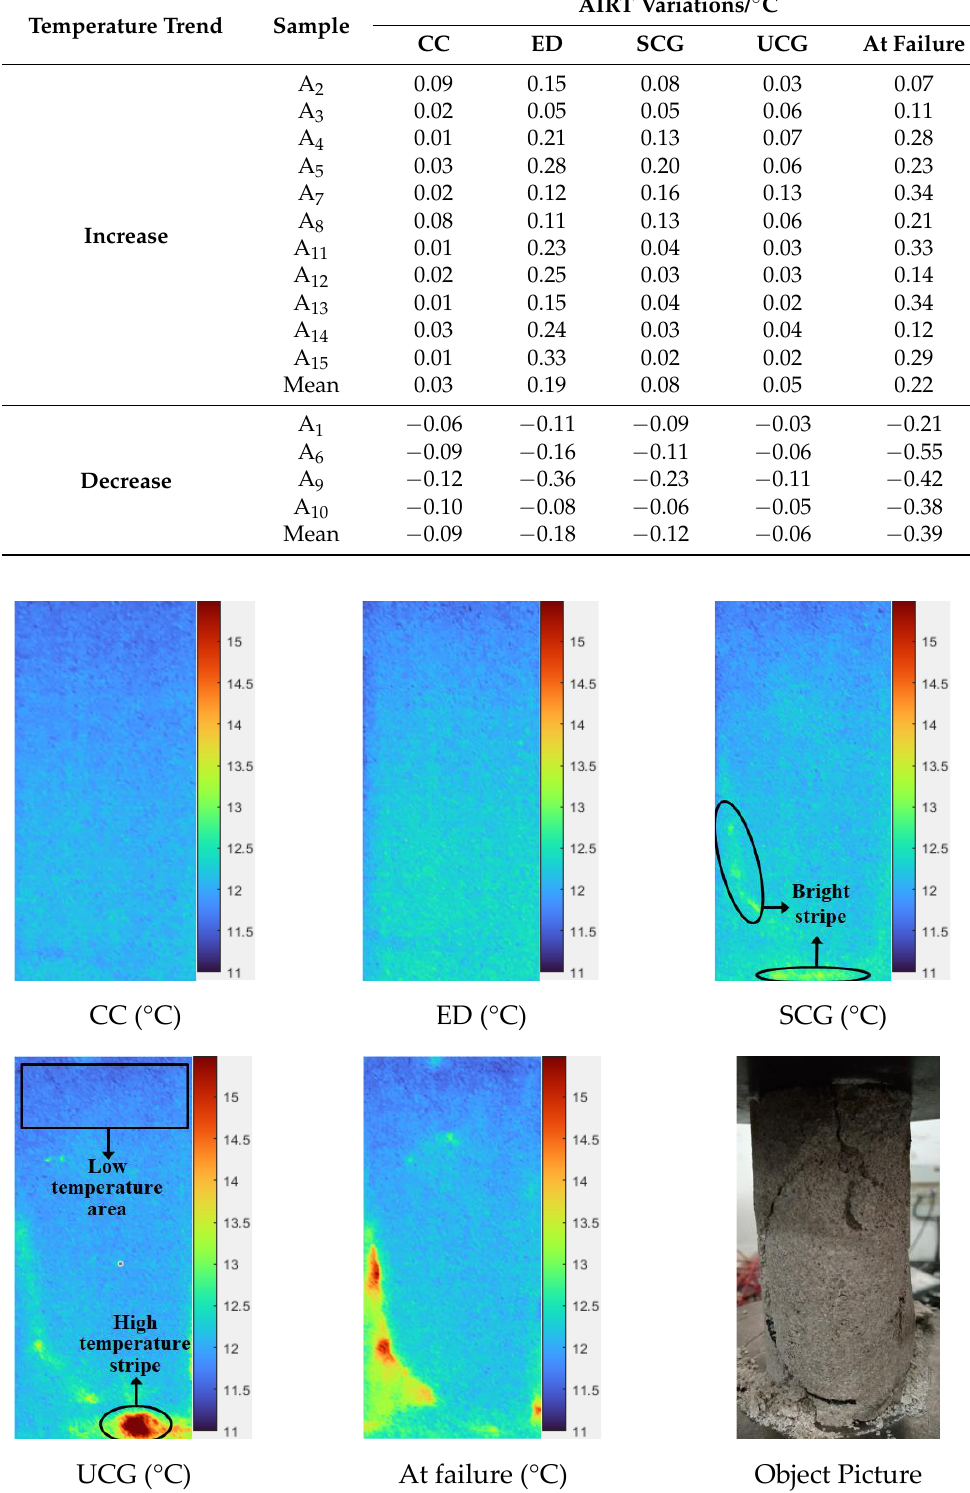
Figure 3. Infrared thermal images (°C) of rock sample A 3 during loading.